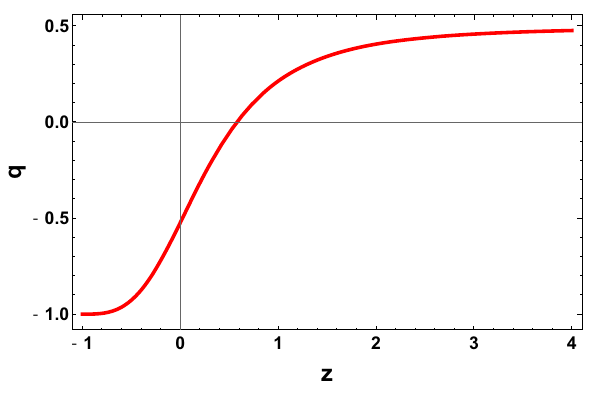
Fig. 4 Variationofdecelerationparameter q ( z ) forthebestfittedvalue of b = 0 . 2, m = 0 . 47 and n = 3 . 2 from the analysis of SNeIa Pantheon samples